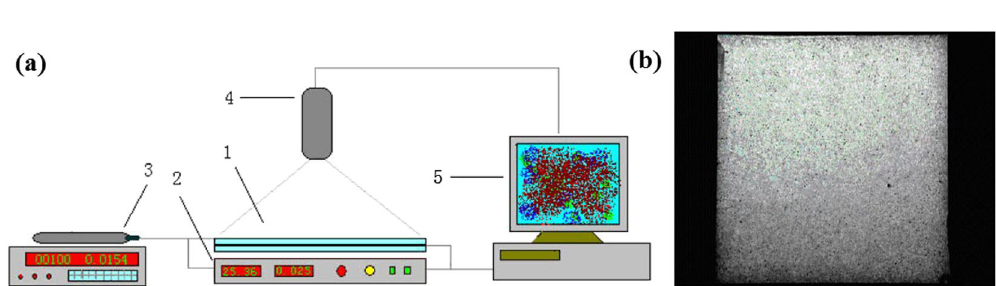
Figure 2. Device and physical model for visual evaluation of oil displacement. ( a ) Device for visually evaluating oil displacement. 1 Transparent visualization model. 2 Thermostatic physical model tank bottom. 3 Micro pump filled with fluid. 4 Camera for continuous, real-time recording of various substances. 5 Computer analyzed image data. ( b ) Physical model of